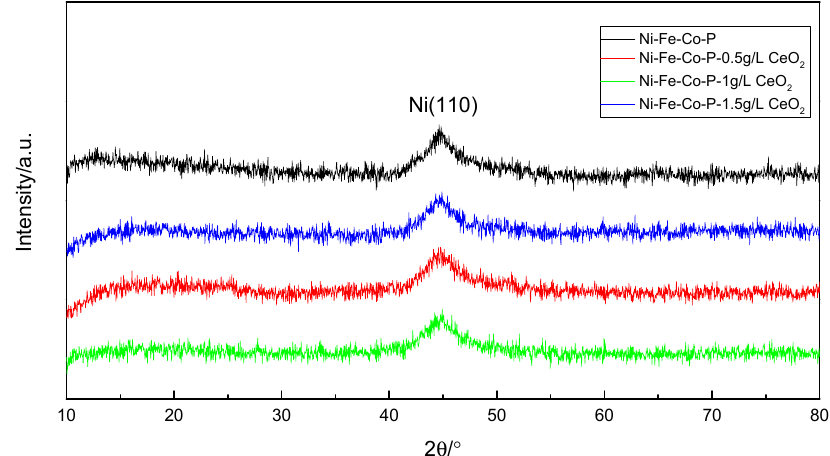
Figure 7. XRD patterns of coatings with di ff erent concentration of nanometer CeO 2 particles.